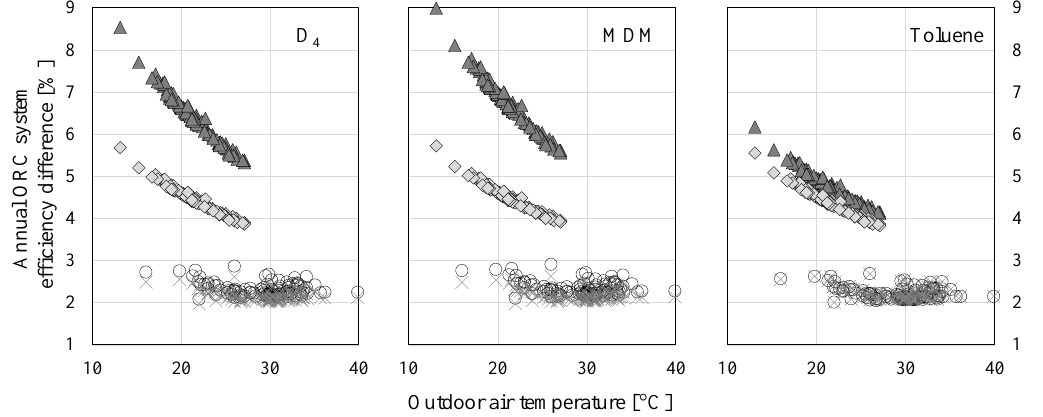
Figure 12. Annual ORC system efficiency relative difference function of nominal outdoor